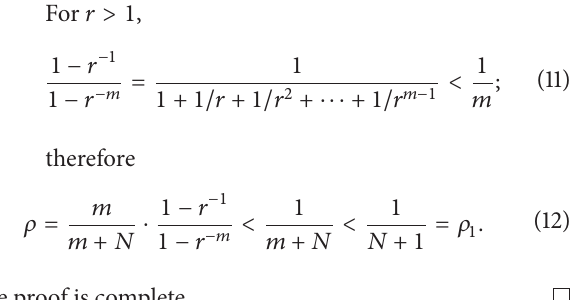
Figure 2: A bilevel EG where the leaders (set 𝐴 ) form an isothermal EG. When they are collapsed into a single vertex, we have a one- rooted EG